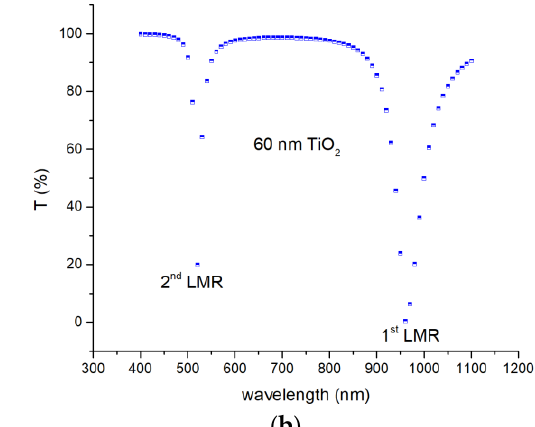
Figure 4. LMR in dependence of lossy cladding thickness: ( a ) resonance wavelength vs. cladding thickness; ( b ) transmittance spectrum at TiO 2 thickness of 60 nm.